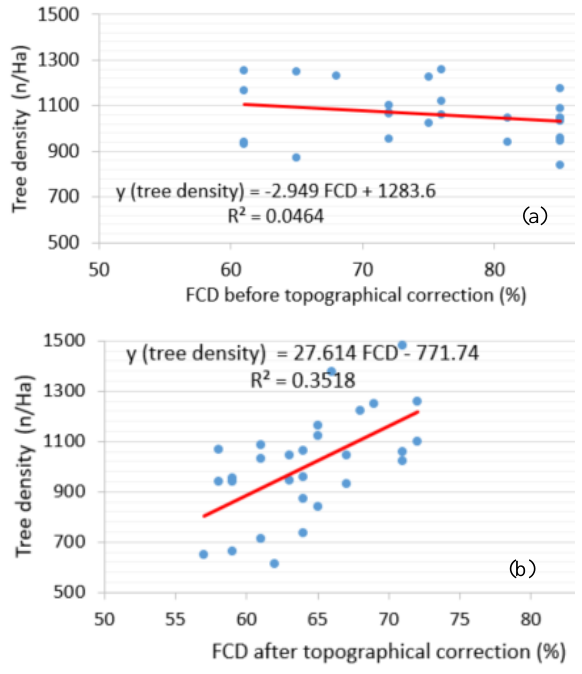
Figure 13. Regression between tree density and FCD, (a) before and (b) after topographic correction